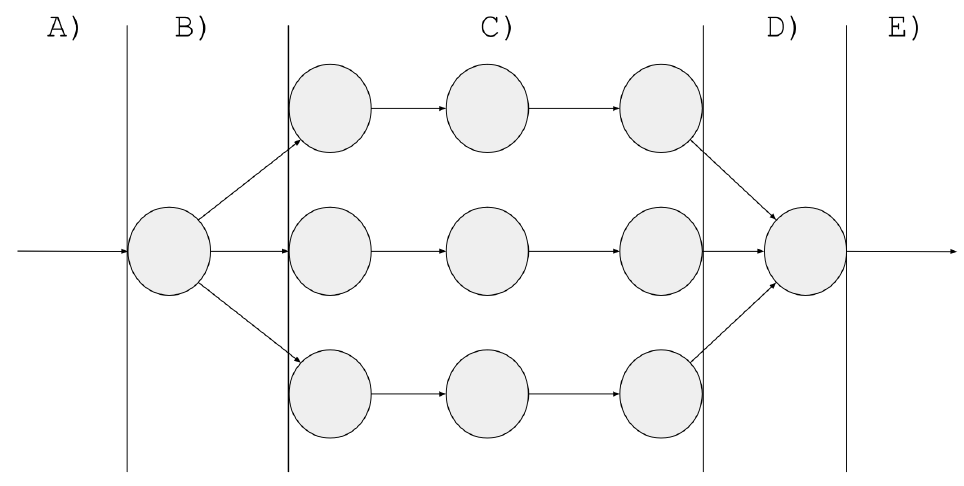
Figure 1. Domain crossing between non-hardened and hardened domains. Each element in the graph may represent either a combinatorial operation or a memory element. ( A ) Non-hardened domain. ( B ) Crossing to hardened domain. ( C ) Hardened domain. ( D ) Crossing to non-hardened domain. ( E ) Non-hardened domain.